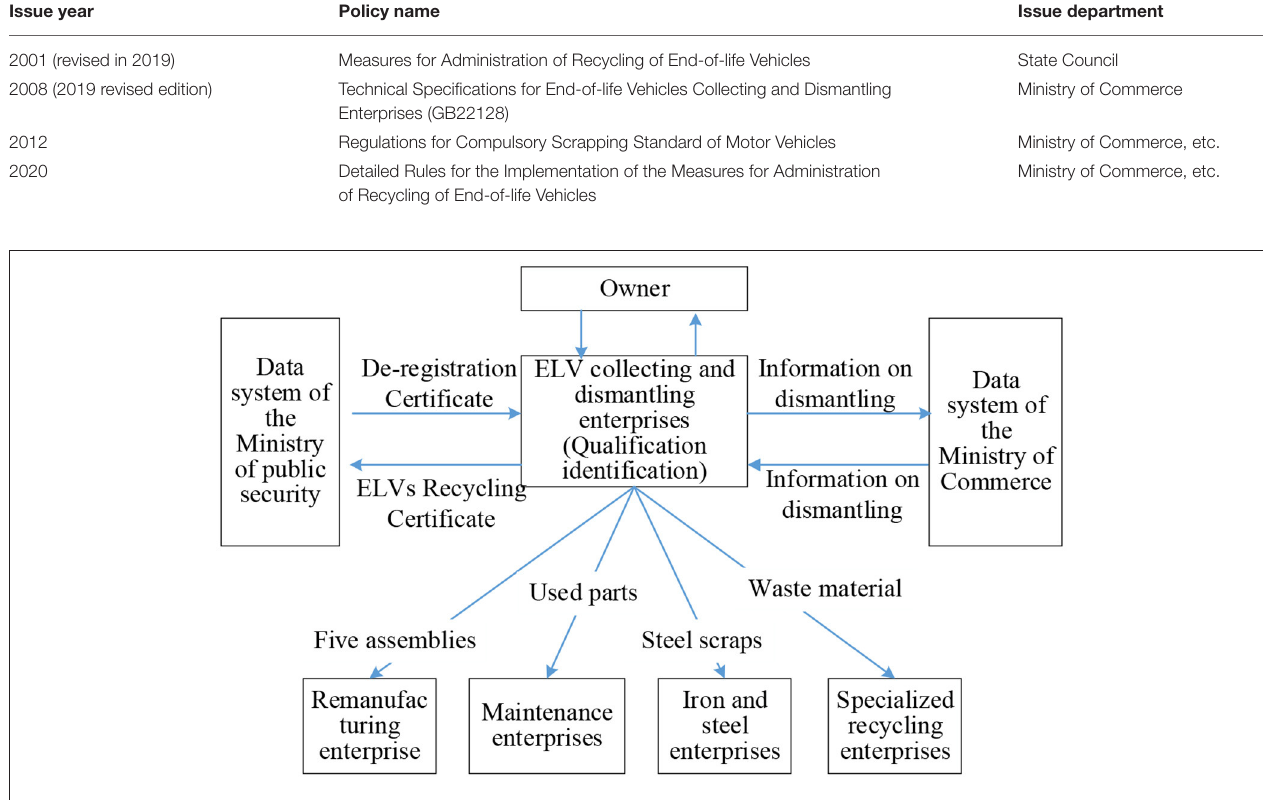
FIGURE 8 | China’s ELV recycling management